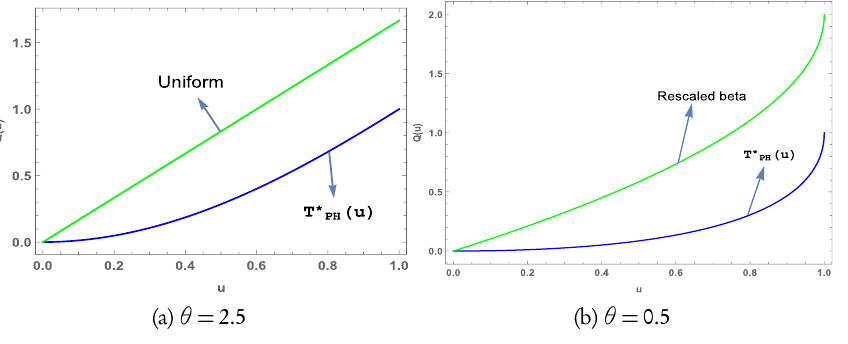
θ ( u ) , and (b) rescaled beta ( 0, 1 ) with T ∗ θ − 1 PH